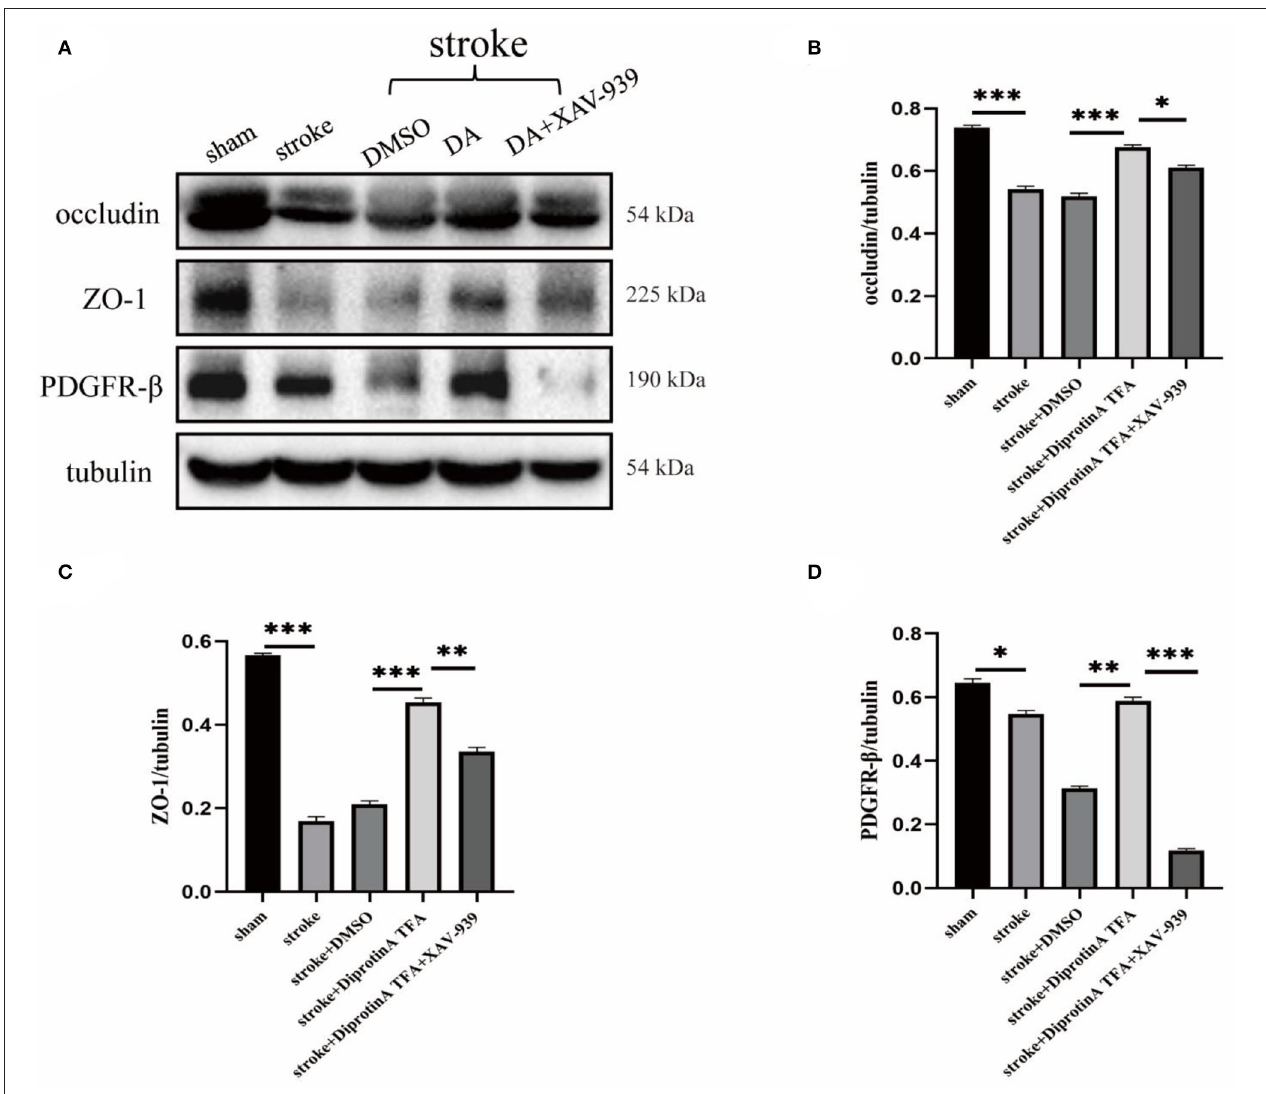
FIGURE 6 | Diprotin A TFA regulates the expression of tight junction protein at the BBB and pericyte. (A) Western blot images of BBB-associated tight junction protein (occludin, ZO-1) and pericyte (PDGFR- β ) in the penumbra tissue of five groups of mice with cerebral ischemic injury. (B–D) The results showed that the expression levels of occludin, ZO-1, and PDGFR- β were upregulated in the group injected with DA compared with the vehicle control group, whereas the expression levels were downregulated in the group injected with DA and β -catenin inhibitor. n = 3 per group. Data are represented as mean with SEM. * p < 0.05, ** p < 0.01, *** p <